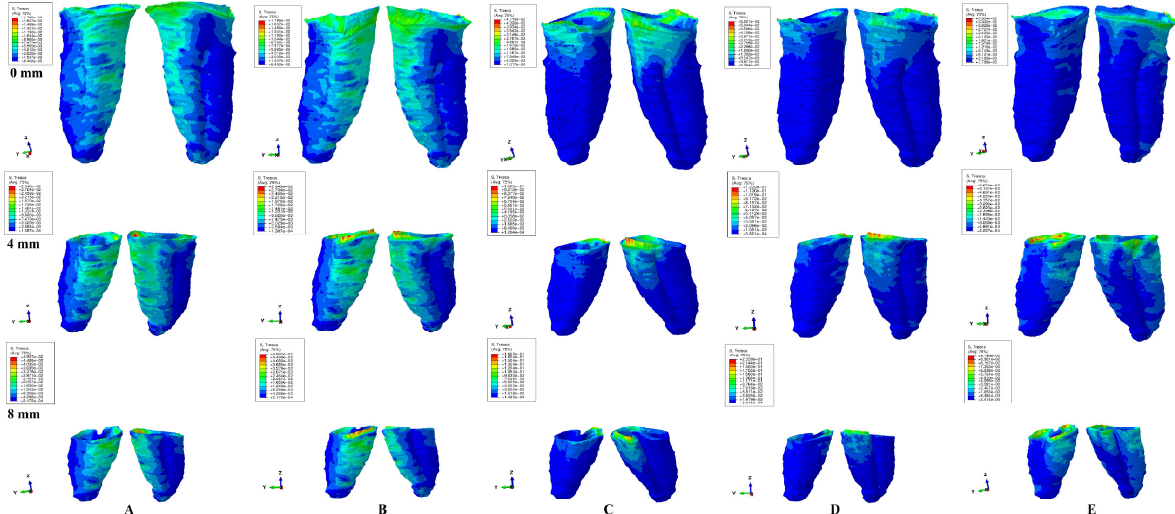
Figure 3. Tresca shear stress display in the PDL for 1.2 N (the quantitative values are in MPa) (intact, 4 mm and 8 mm reduced periodontium—vestibular-distal and mesial-lingual view): ( A )—intrusion, ( B )—extrusion, ( C )—translation, ( D )—rotation, and ( E )—tipping the highest stressed areas are color coded in red and orange. Table 3. The Tresca shear stress average values (KPa) produced by 1.2 N of orthodontic force. Resorption